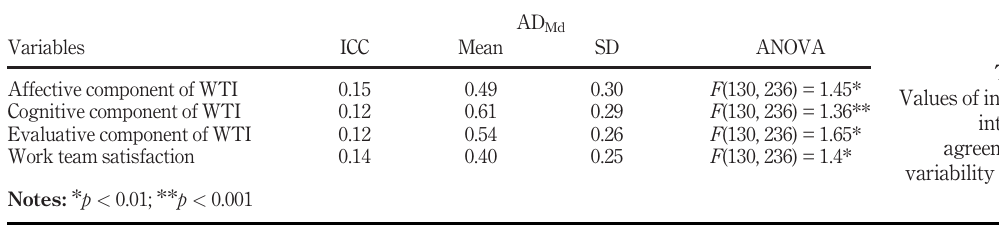
Table I. Values of indexes of